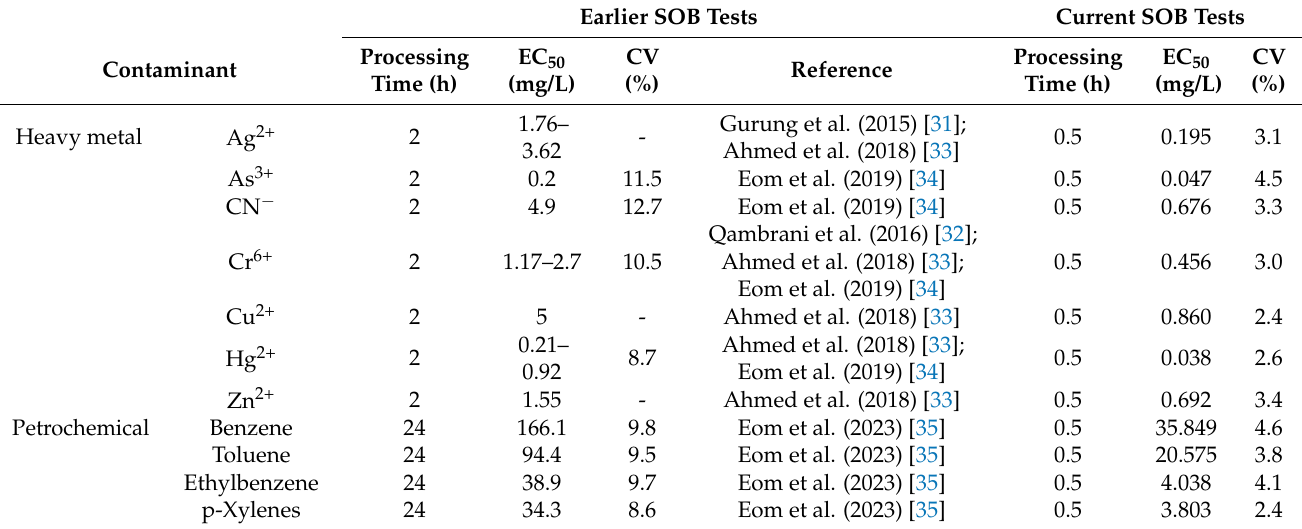
Table 2. Comparisons of results from SOB toxicity tests between the current and earlier